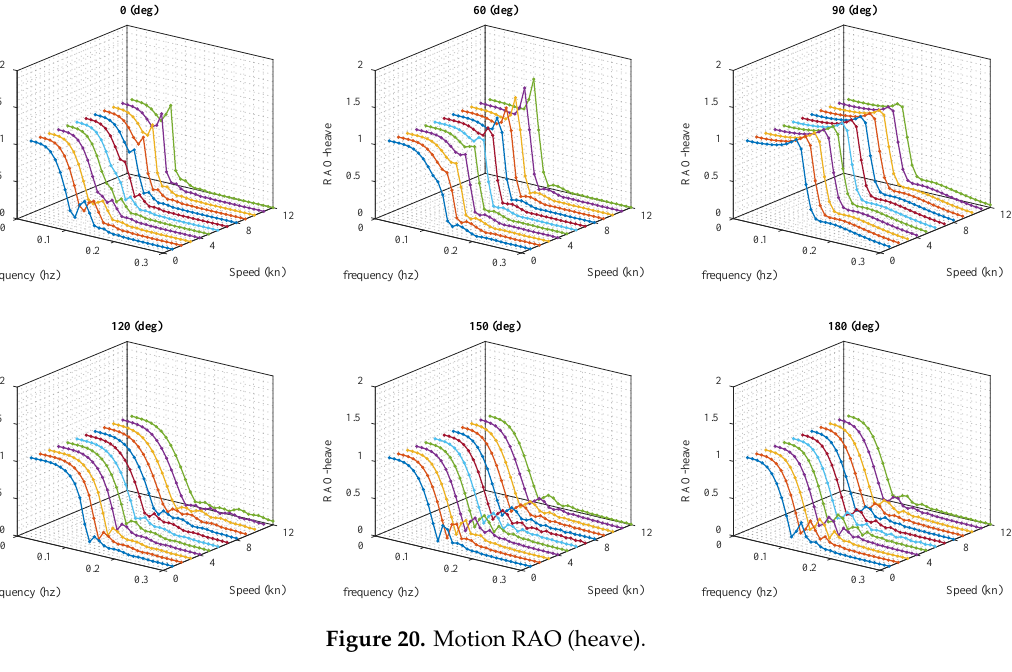
Figure 20. Motion RAO (heave). J. Mar. Sci. Eng. 2019 , 7 , x FOR PEER REVIEW